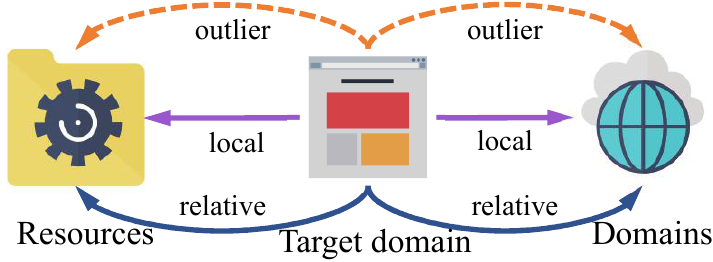
Figure 6. HIN schema in HinPhish.